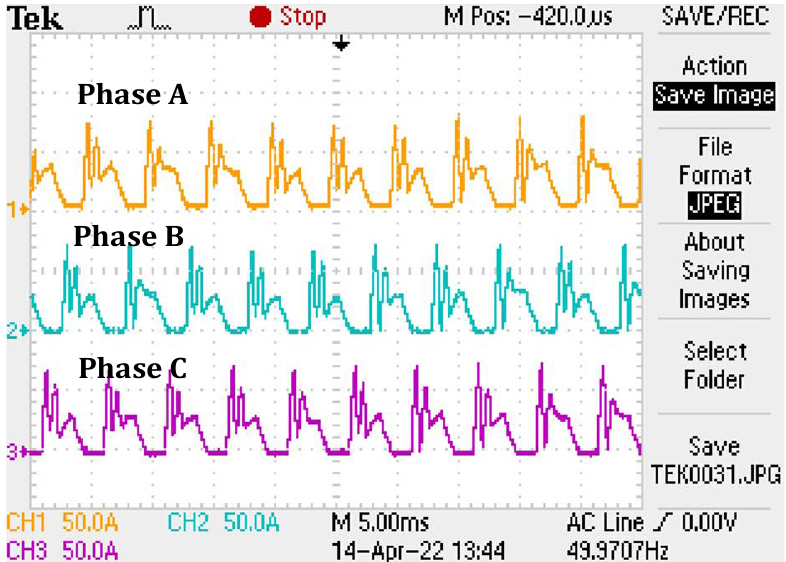
Figure 22. The reference SRM experiment results of the phase current waveforms at 1500 rpm with load.